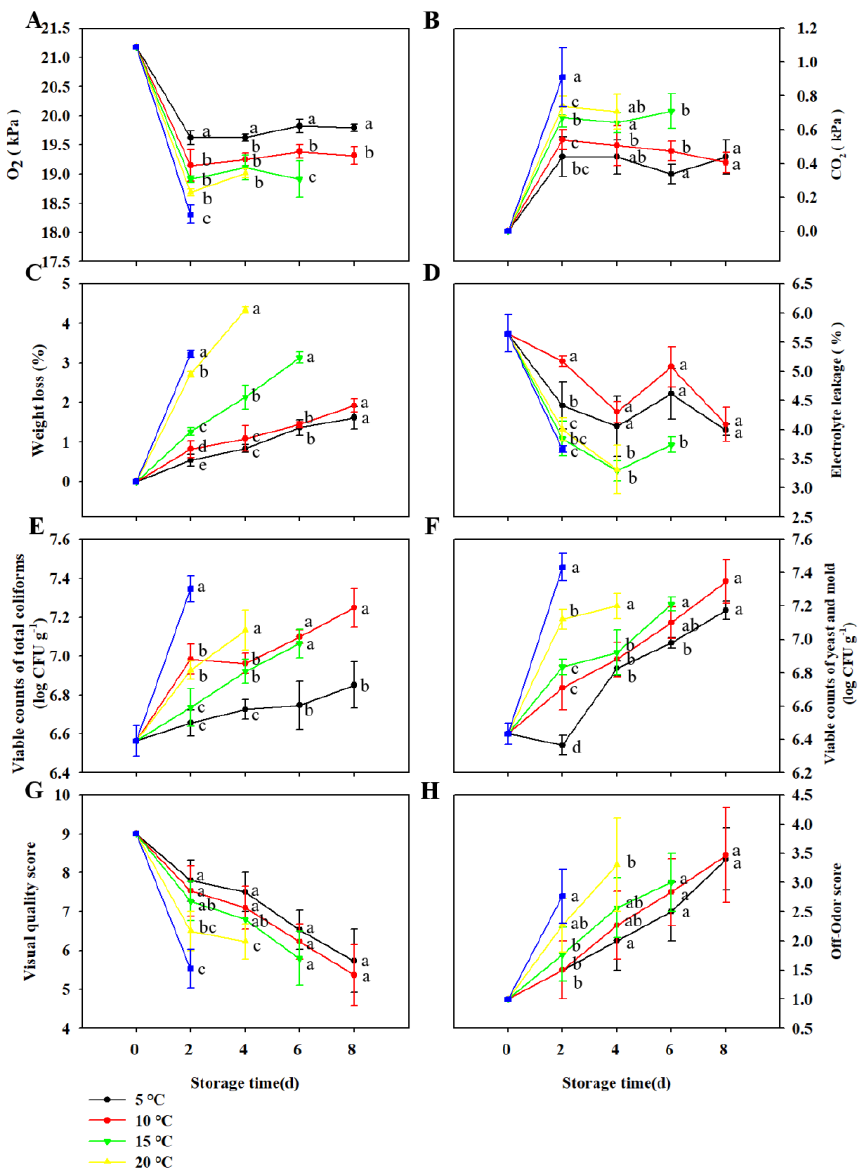
Figure 1. Effect of storage temperature on the changes in O 2 ( A ) and CO 2 ( B ) partial pressures within packages, weight loss ( C ), electrolyte leakage ( D ), counts of total coliforms ( E ) and yeast and mold (Y&M) ( F ), overall quality score ( G ) and off-odor score ( H ) of TBM packed by PE bags. The vertical bar represents ± standard error. Significant differences between samples (within the same time point) are indicated with different lowercase letters above the